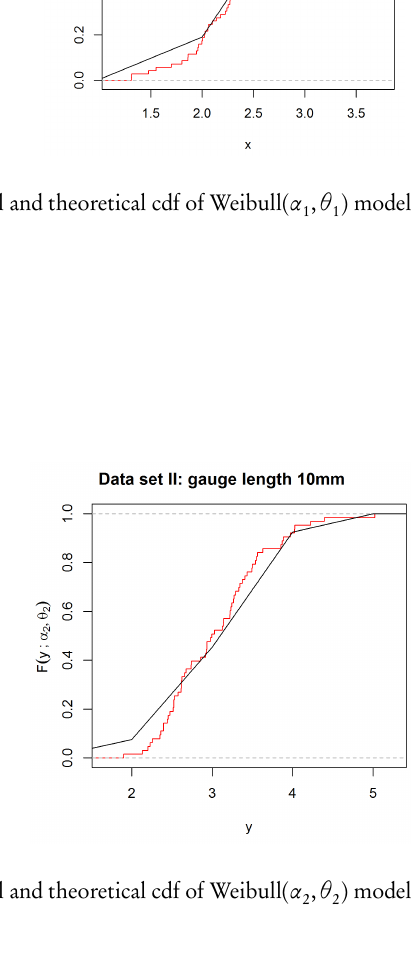
Figure 9 – The empirical and theoretical cdf of Weibull ( α